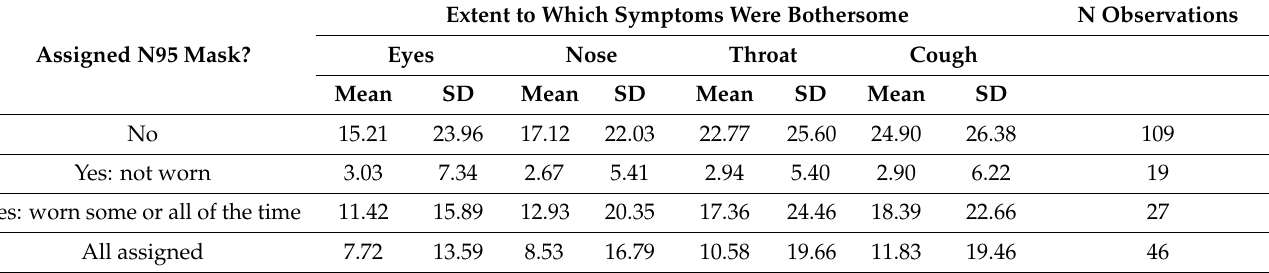
Table 6. Mask wearing by end of rotation